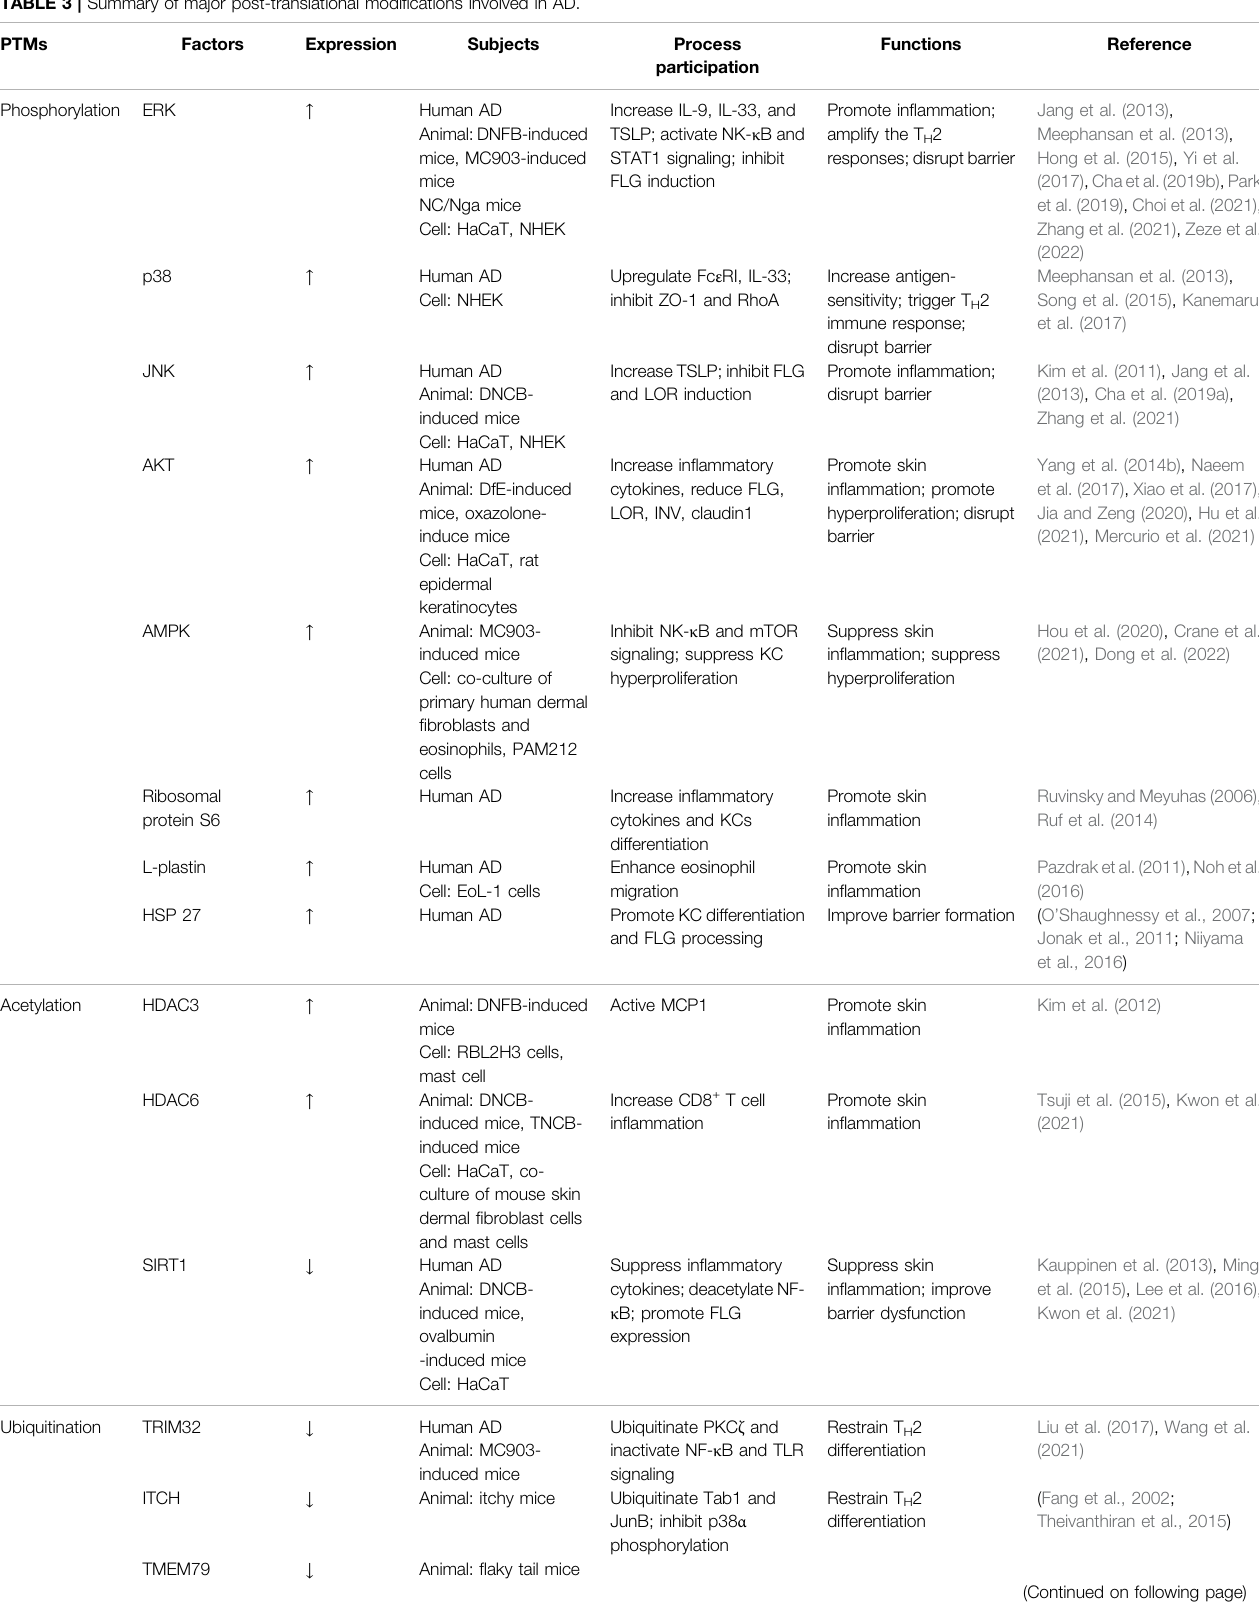
TABLE 3 | Summary of major post-translational modi fi cations involved in